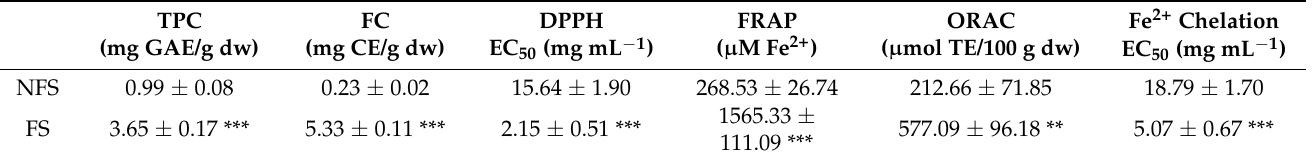
Table 1. Bioactive compounds content (total phenolic and flavonoid content) and in vitro antioxidant activities (DPPH, FRAP, ORAC, and Fe 2+ chelating ability) of fermented (FS) vs. non-fermented spelt (NFS) flour. Results were expressed as mean values ± SD of three replicates. Unpaired Student t -test: * significantly different from NFS: ** p < 0.01, *** p <